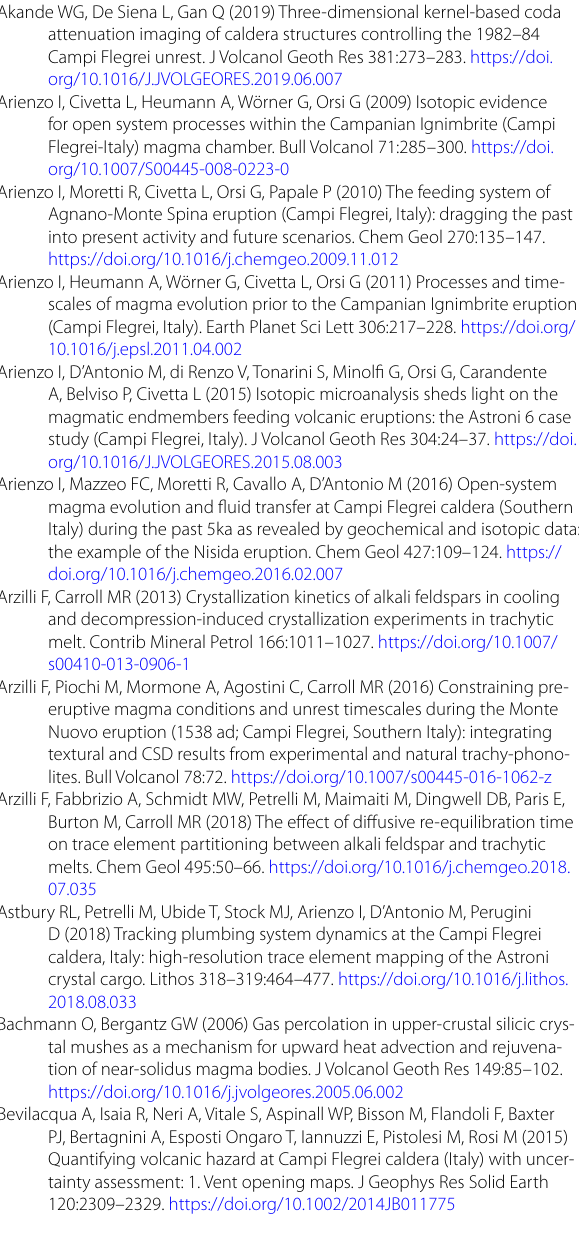
Additional file 1: Table S1 . Physical parameters used in the magma ascent velocities calculations. Table S2 . Viscosities calculated and used for the magma ascent velocity